Question: What kind of plot is shown here?
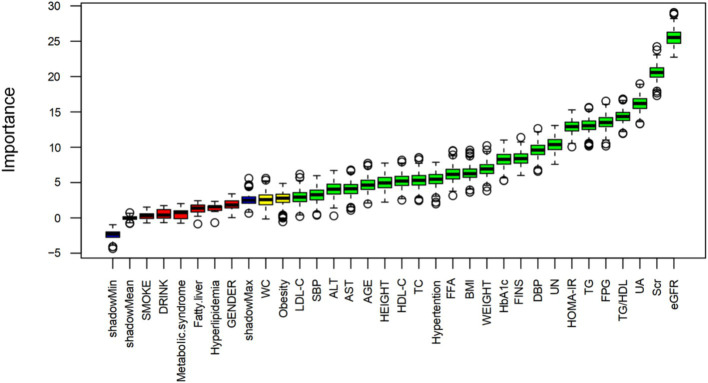
Answer: box